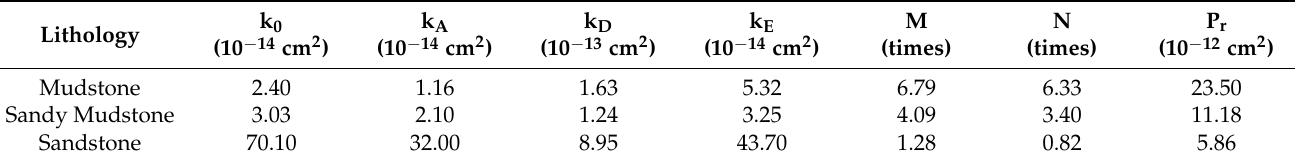
Table 3. Summary of permeability at each stage of mining